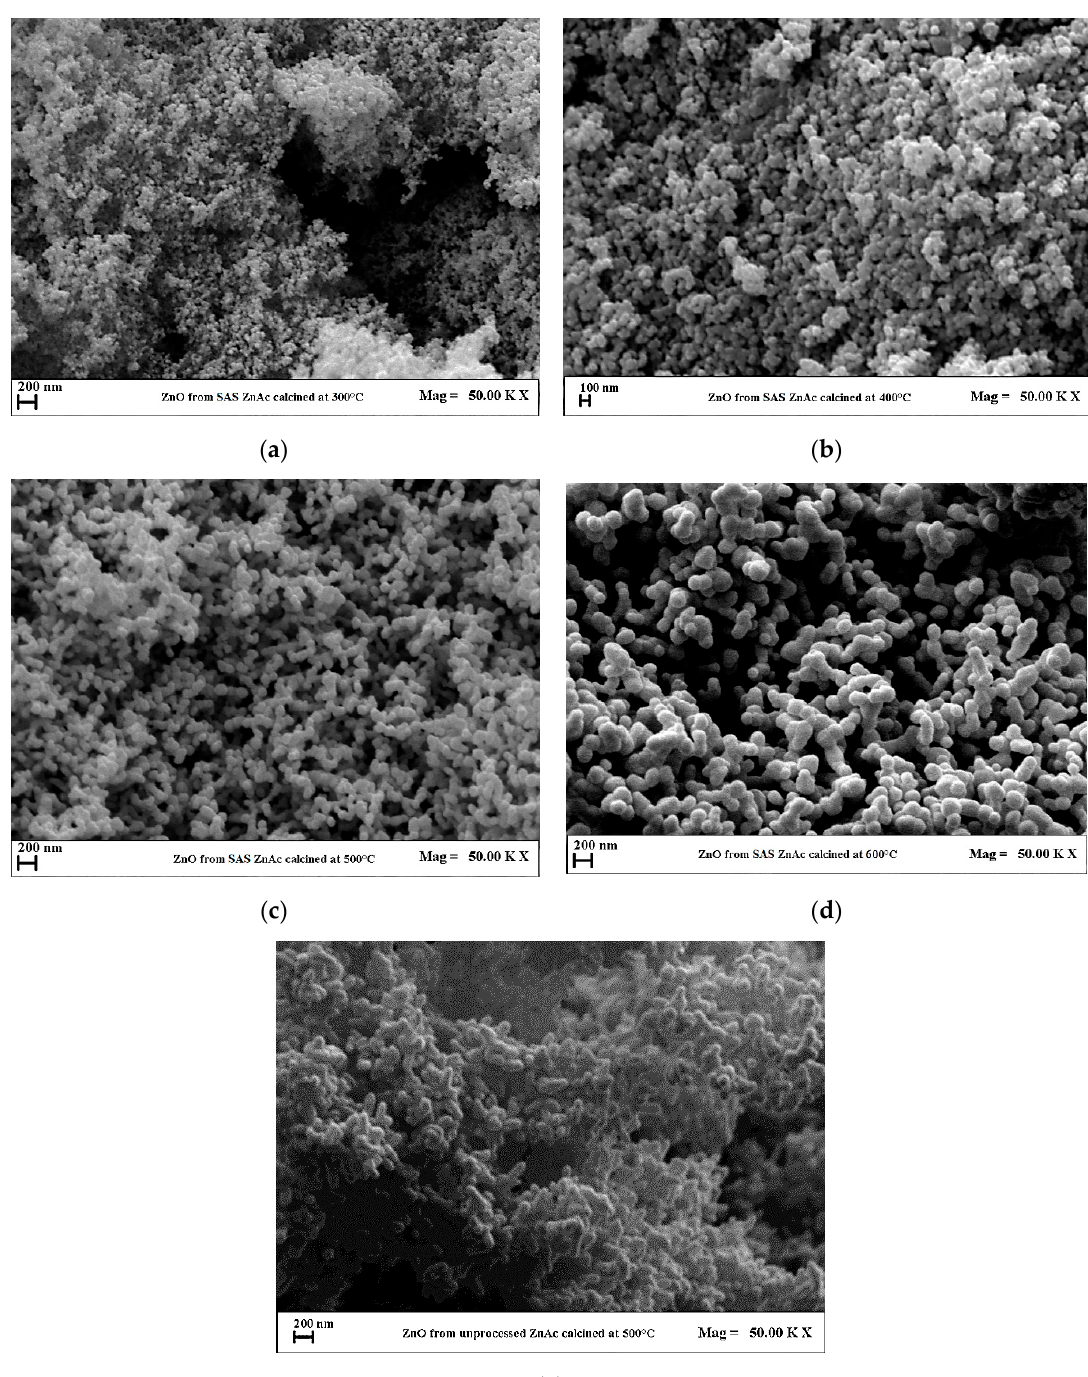
Figure 3. Field emission scanning electron microscope (FESEM) images of zinc oxide (ZnO) nanoparticles obtained from supercritical antisolvent (SAS) processed zinc acetate (ZnAc) calcined at 300 °C ( a ), 400 °C ( b ), 500 °C ( c ), and 600 °C ( d ); and ZnO produced from unprocessed ZnAc ( e ).